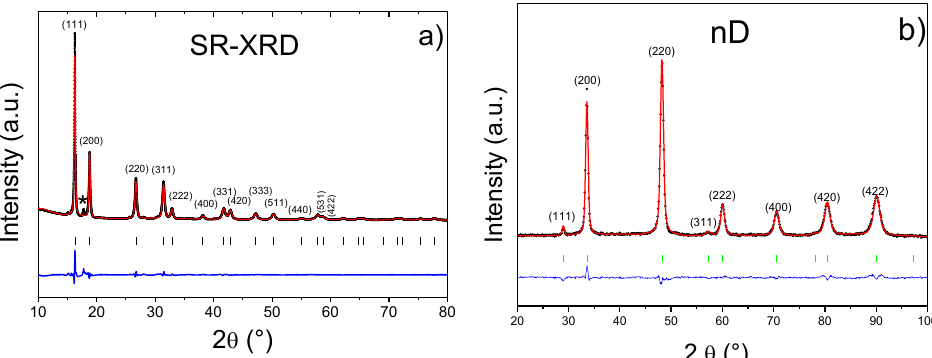
Figure 4. ( a ) SR-XRD pattern ( λ = 0.7289 Å) of the dihydride Ti 0.30 V 0.25 Cr 0.10 Zr 0.10 Nb 0.25 H 2 , and ( b ) nD pattern ( λ = 1.2858 Å) of the deuteride Ti 0.30 V 0.25 Cr 0.10 Zr 0.10 Nb 0.25 D 2 and the corresponding Rietveld analyses. The star symbol indicates the presence of a minor impurity visible only by